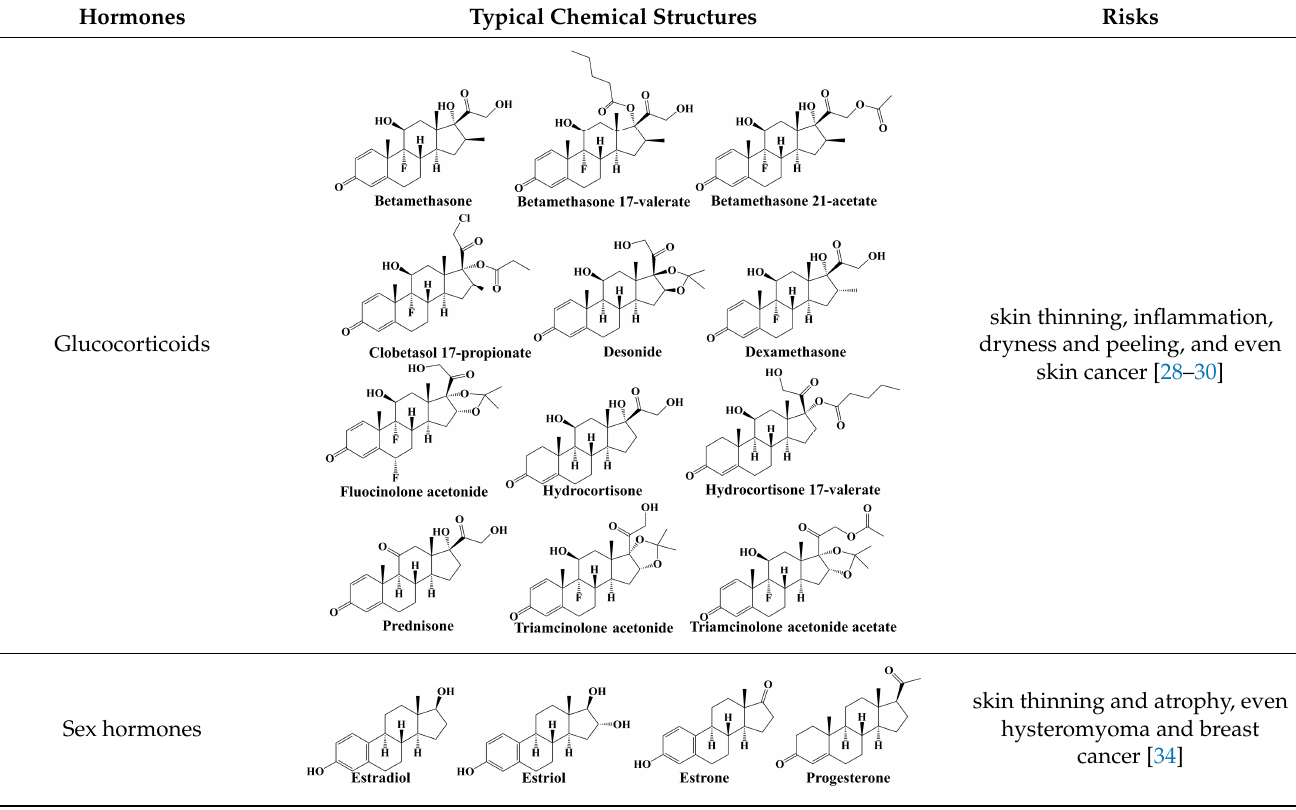
Table 1. Typical hormones in cosmetics and their potential risks for humans. Hormones